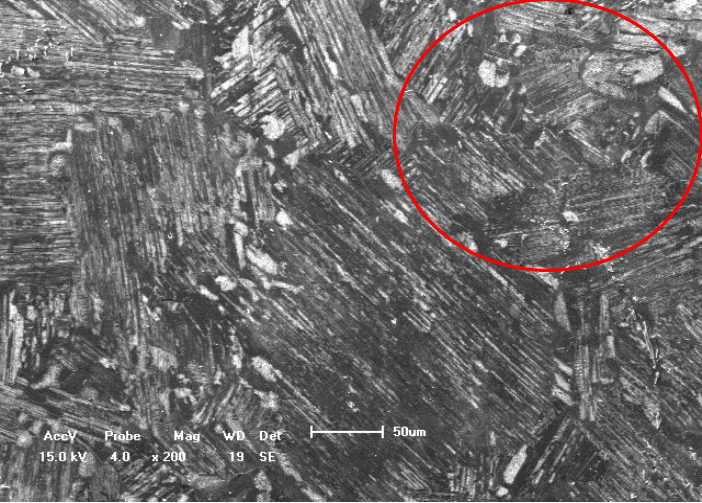
Figure 2. Surface morphology of TiAl alloy with 8% Nb content (bar scale 50 μ